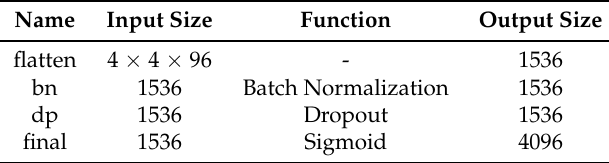
Table 2. Layer description of the fully connected layers which define the final part of our